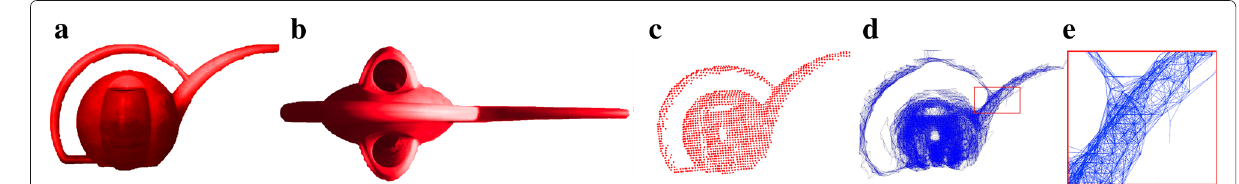
Fig. 12 Graph making from point cloud. a Object (watering can) front view. b Top view. c Point cloud of the object. d Undirected graph constructed from the point cloud. e Zoomed-in view of the part of graph. Every point in the point cloud is a node. All the nodes within a sphere around a node are connected